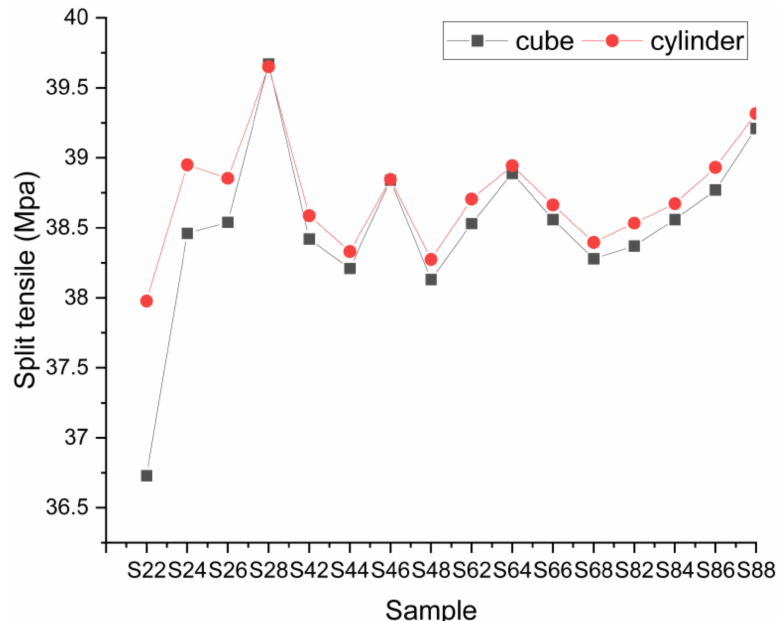
Figure 8. Split tensile strength.